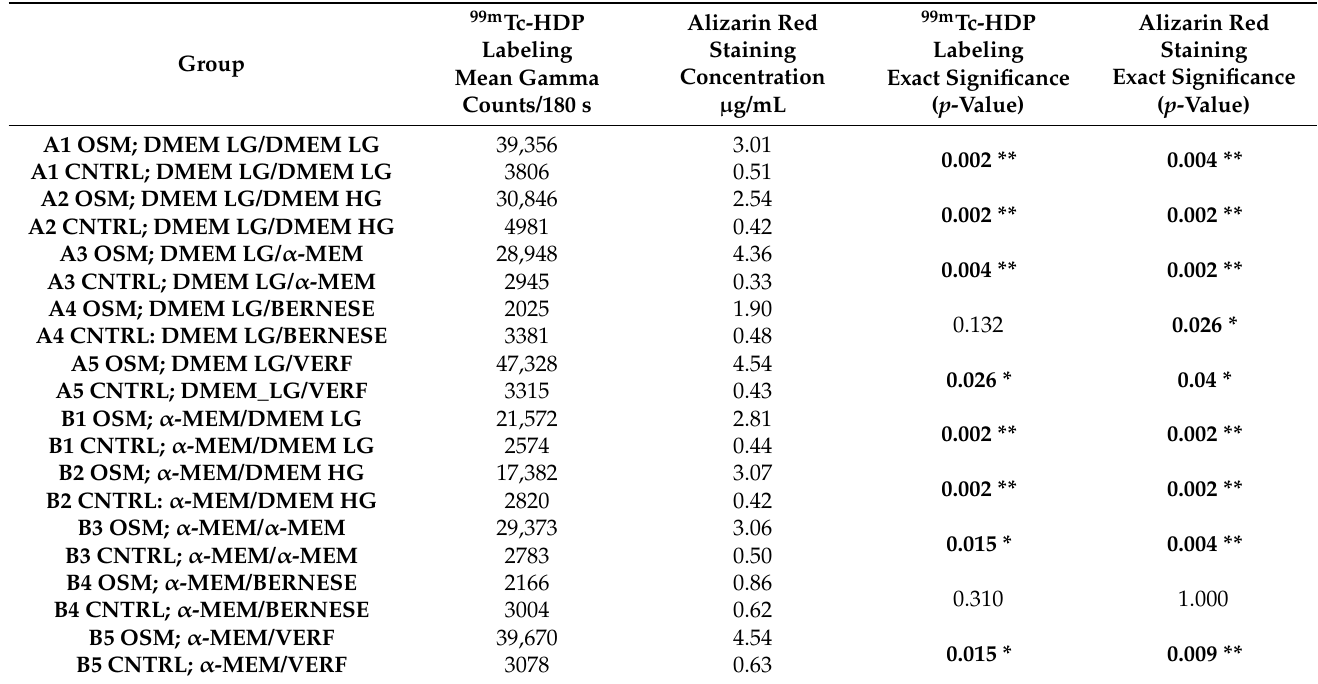
Table 1. Paired Mann–Whitney U Test for each osteogenic group (OSM) and the